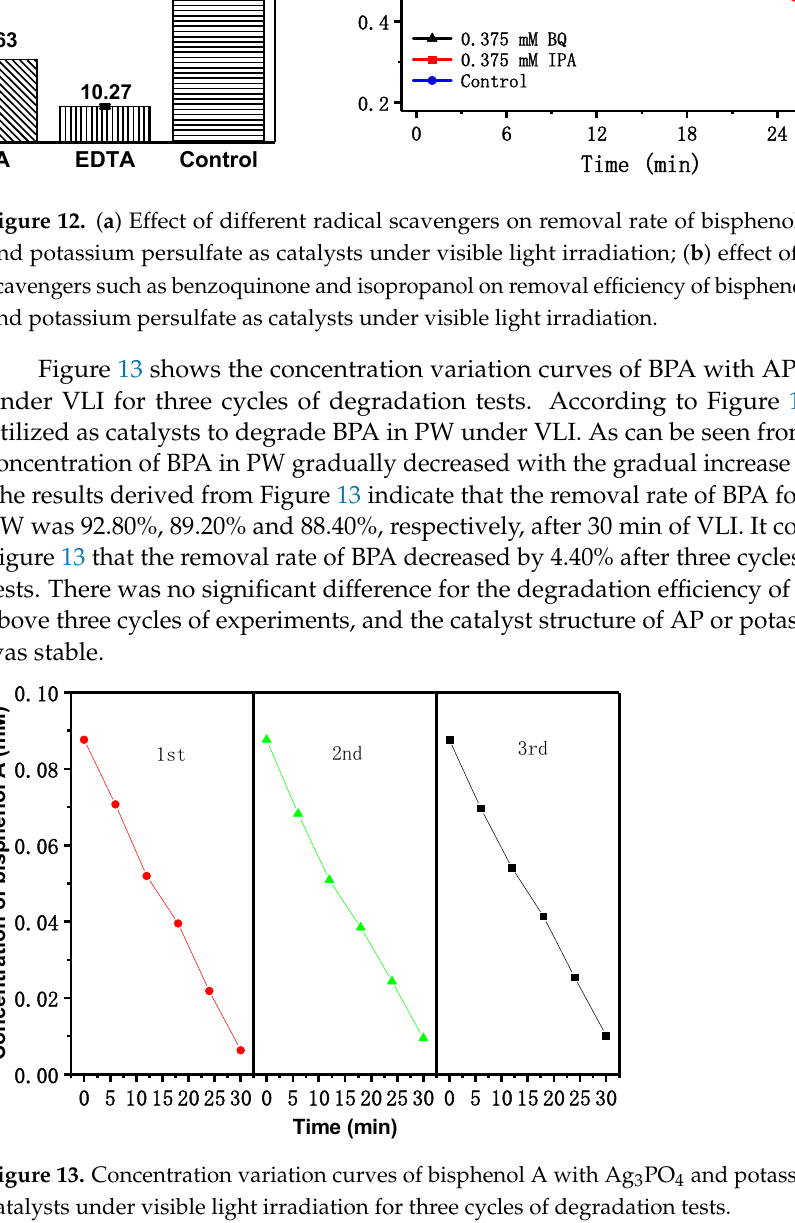
13 of 32 Figure 11. ( a ) The effect of different pH values on removal efficiency of bisphenol A with Ag 3 PO 4 and potassium persulfate as catalysts under visible light irradiation or with potassium persulfate as catalyst under conditions of darkness; ( b ) temporal spectral changes of aqueous solutions of bi- sphenol A with Ag 3 PO 4 and potassium persulfate as catalysts under visible light irradiation at pH = 10.9. Figure 12 shows the effects of different radical scavengers on the removal rate of BPA with AP-PS as catalysts under VLI. The different radical scavengers were separately added to the BPA solution at the beginning of the photocatalytic experiment to determine the active species during the process of degrading BPA. Isopropanol (IPA) was utilized to capture hydroxyl radicals ( • OH), benzoquinone (BQ) was used to capture superoxide an- ions ( • O 2 − ) and ethylenediaminetetraacetic acid (EDTA) was utilized to capture holes (h + ). The scheming IPA concentration, BQ concentration or EDTA concentration was 0.15